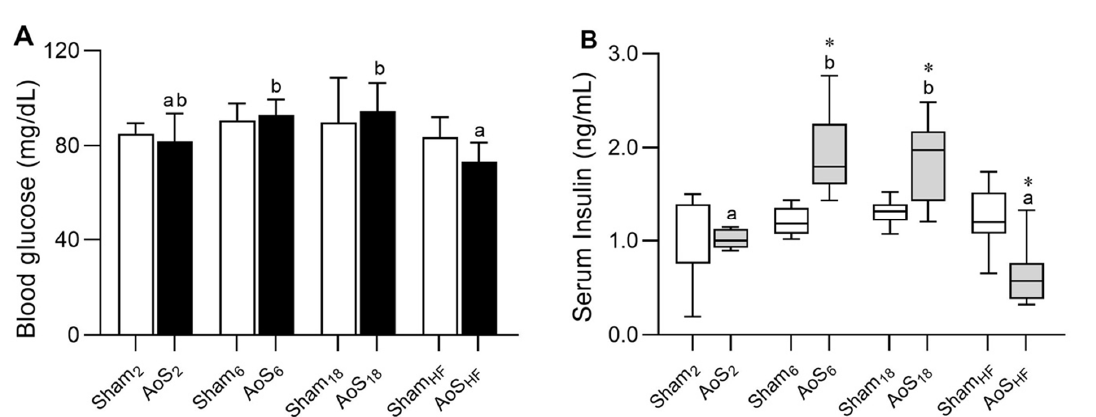
6 of 20 Figure 4. Hypoxia ‐ inducible factor ‐ 1 α ( HIF ‐ 1 α ) protein expression evaluated by Western blot. ( A ) Quantification of HIF ‐ 1 α . ( B ) Representative bands of protein. Sham: operated control; AoS: su ‐ pravalvar aortic stenosis; HF: heart failure; Sham 2 : Sham 2 weeks; Sham 6 : Sham 6 weeks; Sham 18 : Sham 18 weeks; Sham HF : Sham HF; AoS 2 : AoS, 2 weeks; AoS 6 , 6 weeks; AoS 18 , 18 weeks; AoS HF , HF. ISC: Internal control of the sample; AU: arbitrary unity. Data are expressed as mean ± SD and ana ‐ lyzed by ANOVA and Tukey, p < 0.05. *AoS vs. respective Sham. Distinct letters signify statistical difference between moments ( n = 8 animals for each group).